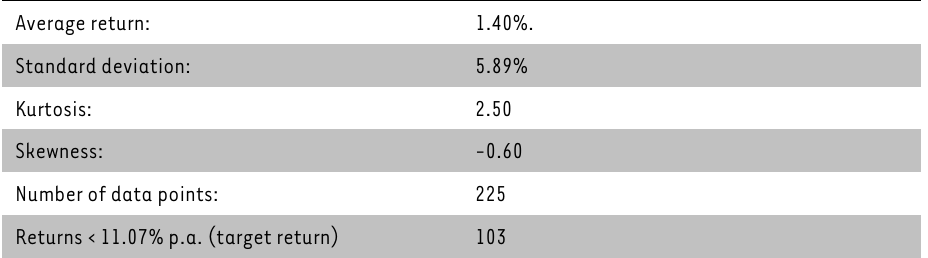
Volatility analysis of the monthly returns of the